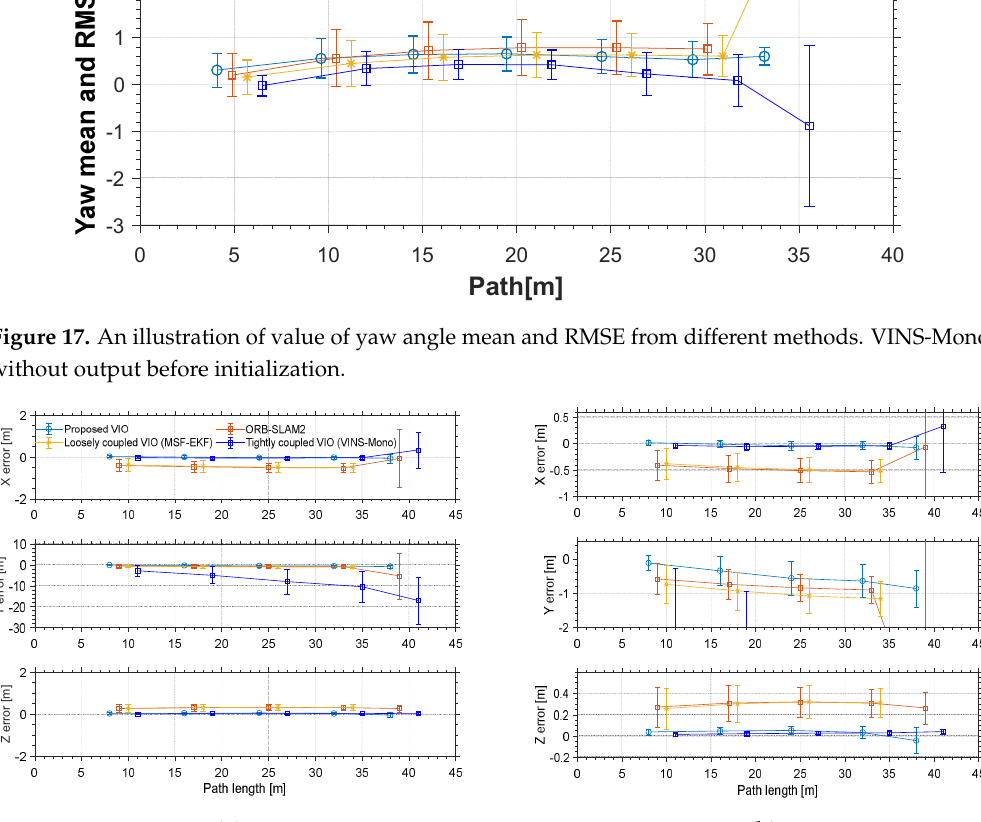
Figure 18. ( a ) The value of mean error and RMSE error of motion estimation from different methods. ( b ) An illustration of partial enlargement.